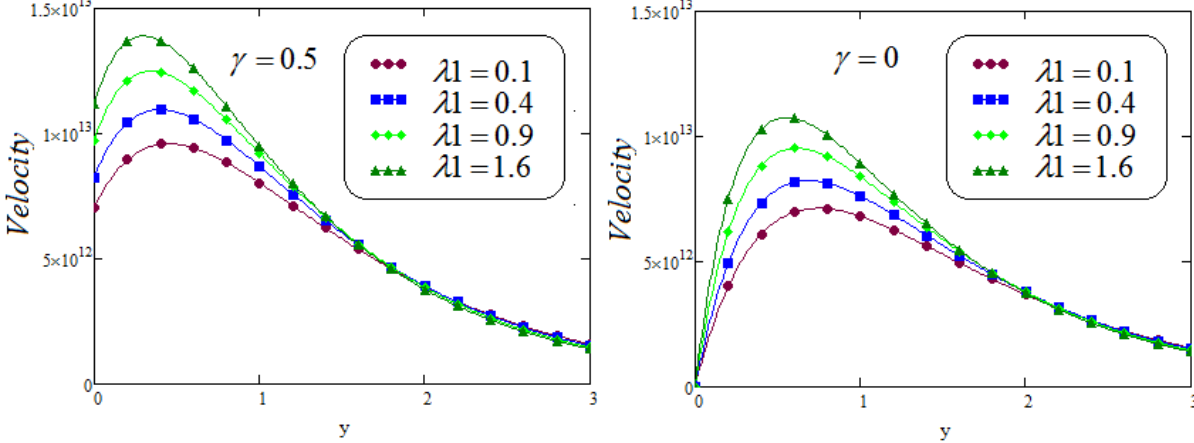
Figure 6. Velocity for varied values of λ 1 with and without slip effect γ when f ( t ) = e at , a = 0.25, t = 1.5, α = 0.5, β = 0.3, Gr = 3.5, P r = 0.71, λ 2 = 0.2, M =